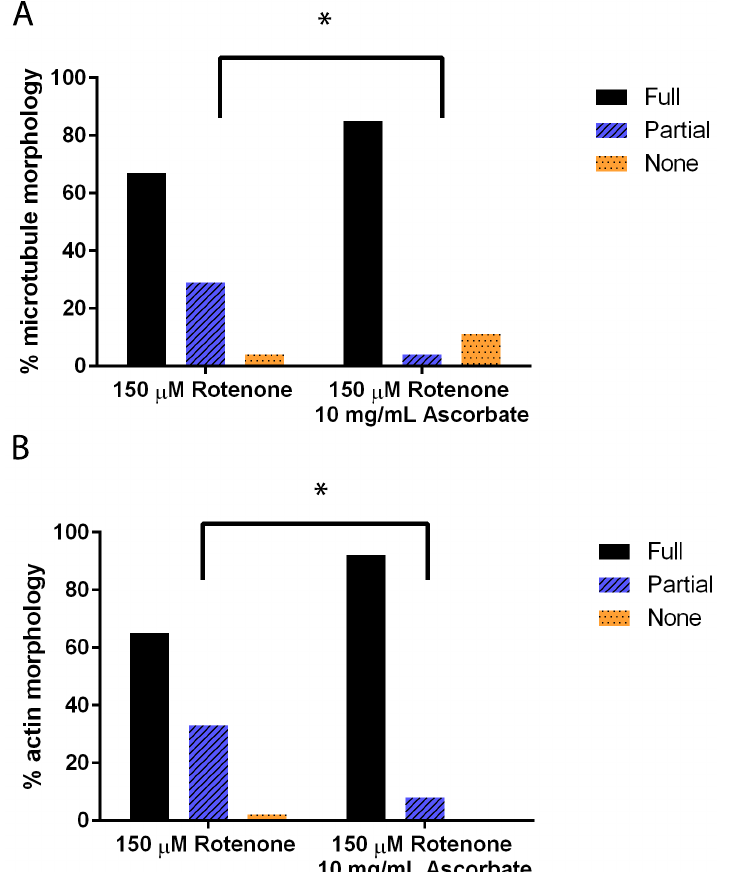
Figure 6. Cytoskeleton morphology in cells treated with rotenone and 0 mg/mL or 10 mg/mL of ascorbic acid. ( A ) Microtubule structures were significantly more assembled in cells when treated with ascorbic acid than rotenone-treated alone ( p = 0.0017). ( B ) Actin networks were significantly more assembled in cells when treated with ascorbic acid than rotenone-treated alone ( n ≥ 40) ( p = 0.0032). * indicates significant difference between